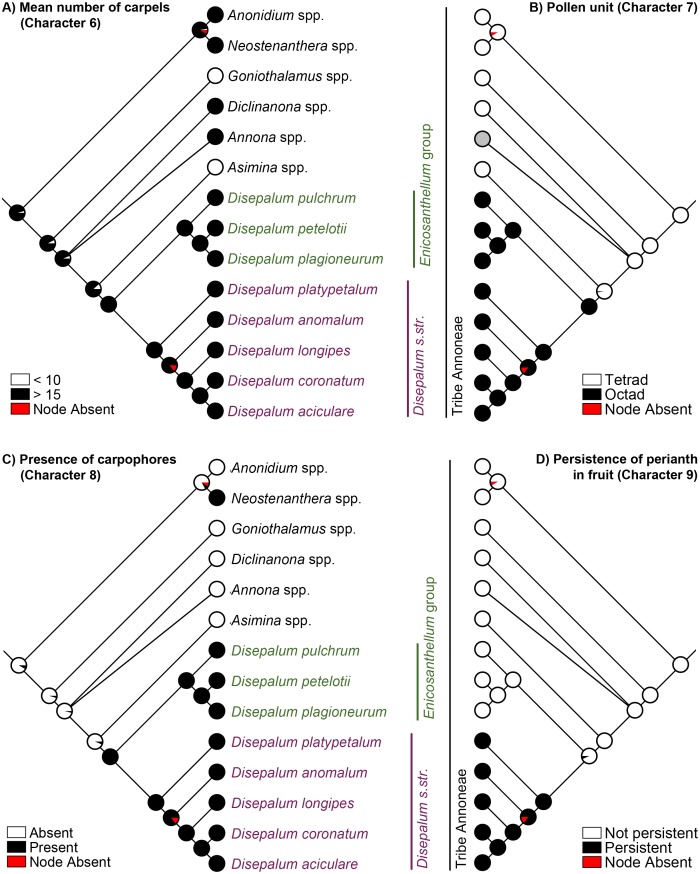
Likelihood ancestral character state estimation for Disepalum and the tribe Annoneae across 90,000 Bayesian input trees, mapped on the Bayesian majority-rule consensus tree under a partitioned model based on combined cpDNA (matK, trnL-F, ndhF and ycf1) and nDNA (AP3 and phyA) sequence data.(A) Mean number of carpels (character 6). (B) Pollen unit (character 7). (C) Presence of carpophores (character 8). (D) Persistence of perianth in fruit (character 9). Pie charts at each node show the percentage of node absence in the input trees and the average likelihood received by each state across all input trees possessing that node. Grey circles indicate unknown character states.